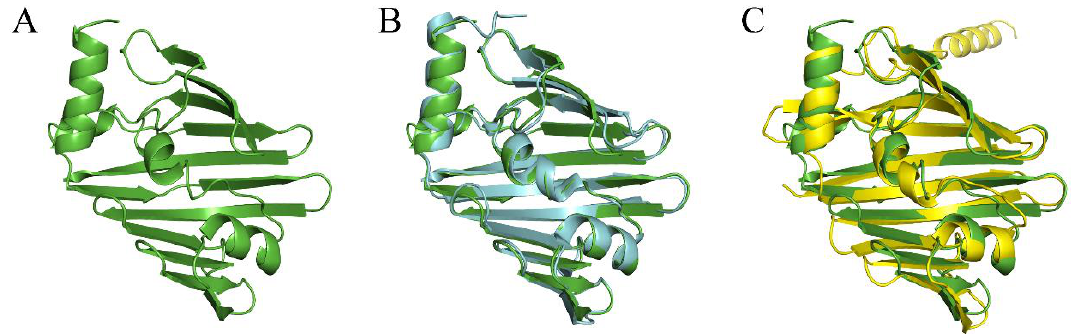
Figure 1. Homology model of V. parahaemolyticus LolB protein. ( A ): V. parahaemolyticus LolB (residues 36-211) modeled by Swiss-model. ( B ): Superposition of V. parahaemolyticus LolB model (green) with E. coli LolB crystal structure (cyan, PDB 1IWM). The rmsd was 0.374 over 137 C α . ( C ): Superposition of V. parahaemolyticus LolB model (green) with full-length structure of V. parahaemolyticus LolB (yellow) predicted by Alphafold. The rmsd was 1.033 over 141 C α . Table 1. The top 10 compounds targeting LolB obtained from virtual screening.